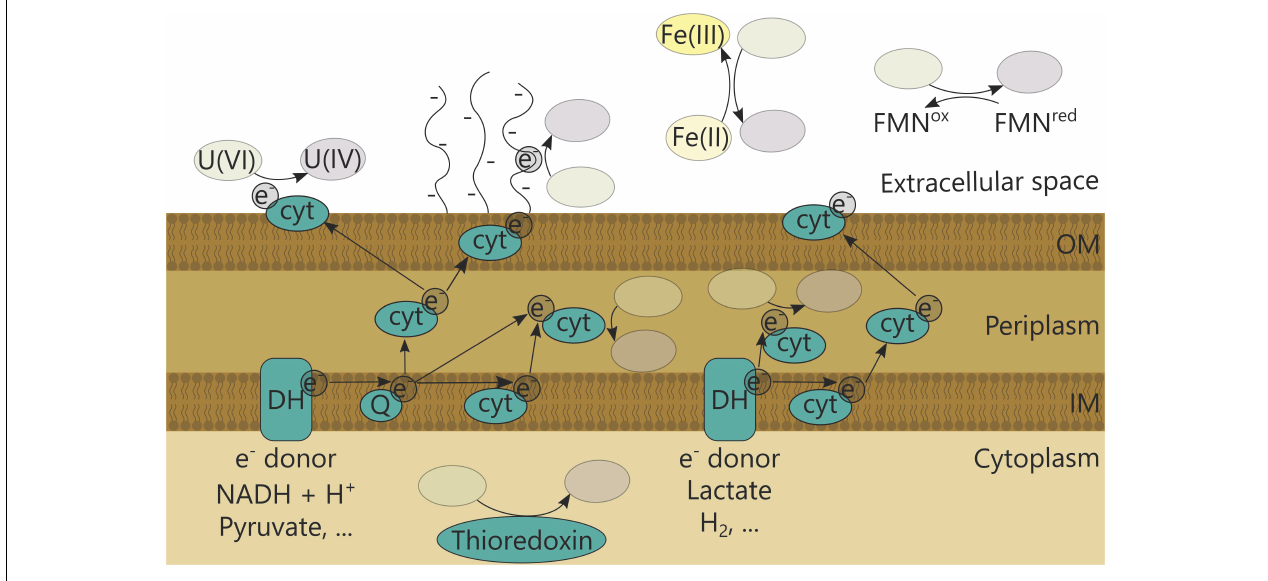
FIGURE 2 | Bacterial uranium reduction mechanisms. DH, Dehydrogenase; Q, quinone; cyt, cytochrome; FMN, flavin